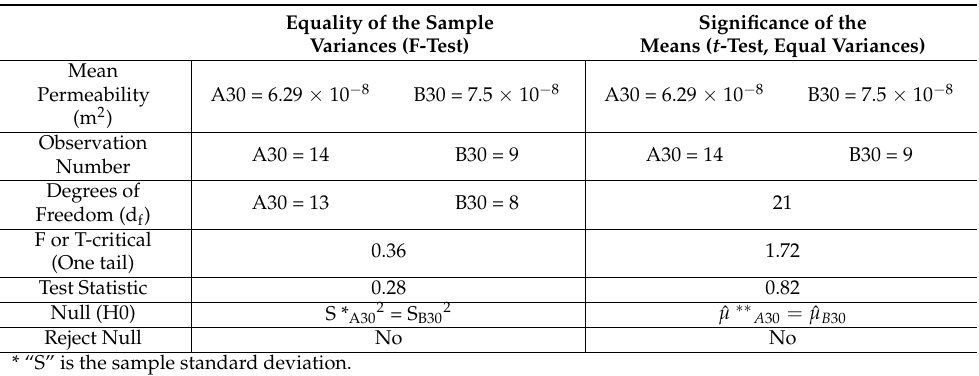
Table 5. The descriptive statistics of the F-Test, examining the equality of the variances of the permeabilities of the CFF samples and subsequently testing the significance of the variation of their mean permeability using the t -test. The CFFs tested were Grade 30 from supplier A and 30 PPI from supplier B. Equality of the Sample Significance of the Variances (F-Test) Means ( t -Test, Equal Variances)